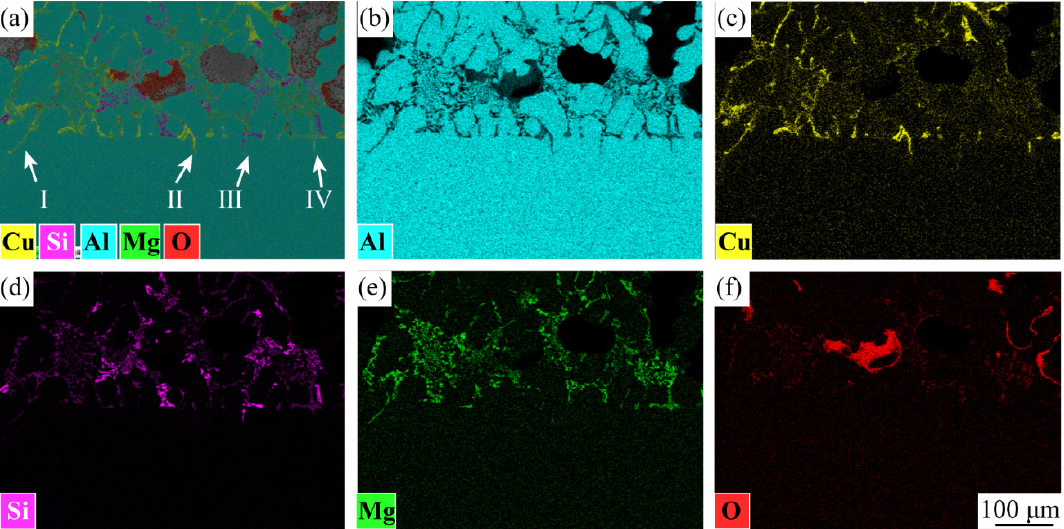
Figure 5. Distribution of elements at the core–panel interface: ( a ) all elements distribution, ( b ) Al distribution, ( c ) Cu distribution, ( d ) Si distribution, ( e ) Mg distribution, ( f ) O distribution.